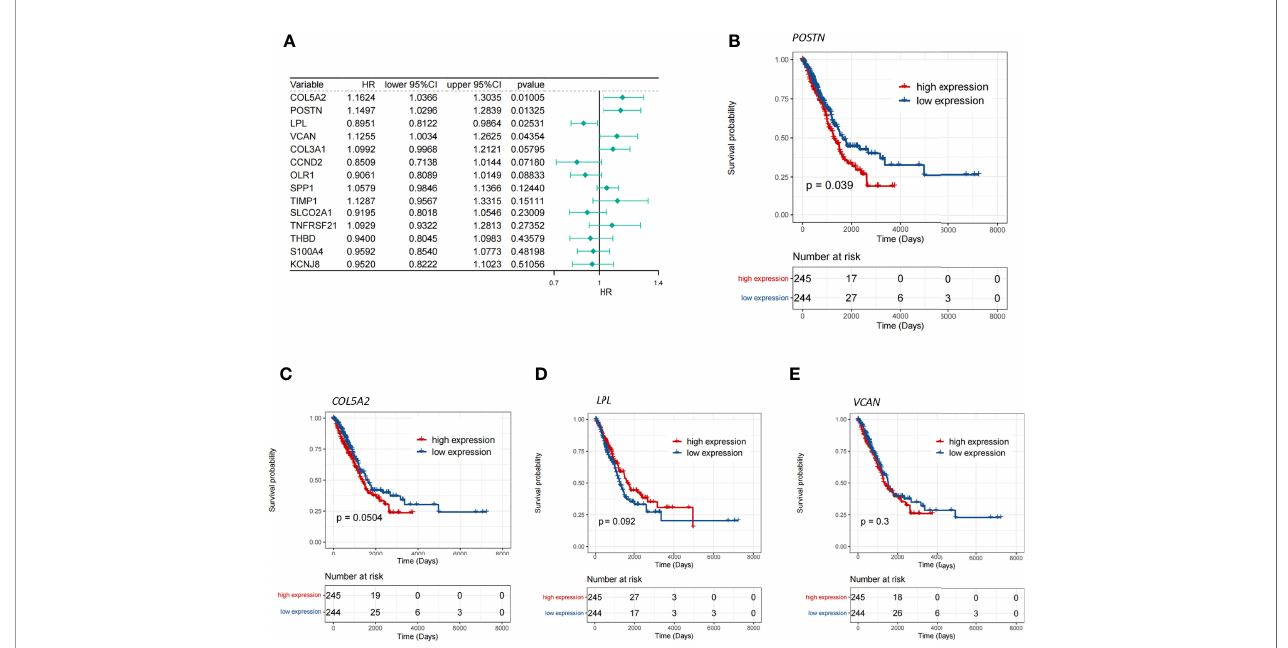
FIGURE 2 | Screening of the key genes for angiogenesis. (A) Single-factor Cox analysis of angiogenic differentially expressed genes. HR is the risk ratio, and lower/ upper 95% CI is the 95% con fi dence interval of the value at risk. (B) Survival differences between the high- and low- POSTN -expression groups, and patients with a high expression of POSTN showed poor overall survival ( p = 0.039). (C) Survival differences between the high- and low- COL5A2 -expression groups. (D) Survival differences between the high- and low- LPL -expression groups. (E) Survival differences between the high- and low- VCAN -expression